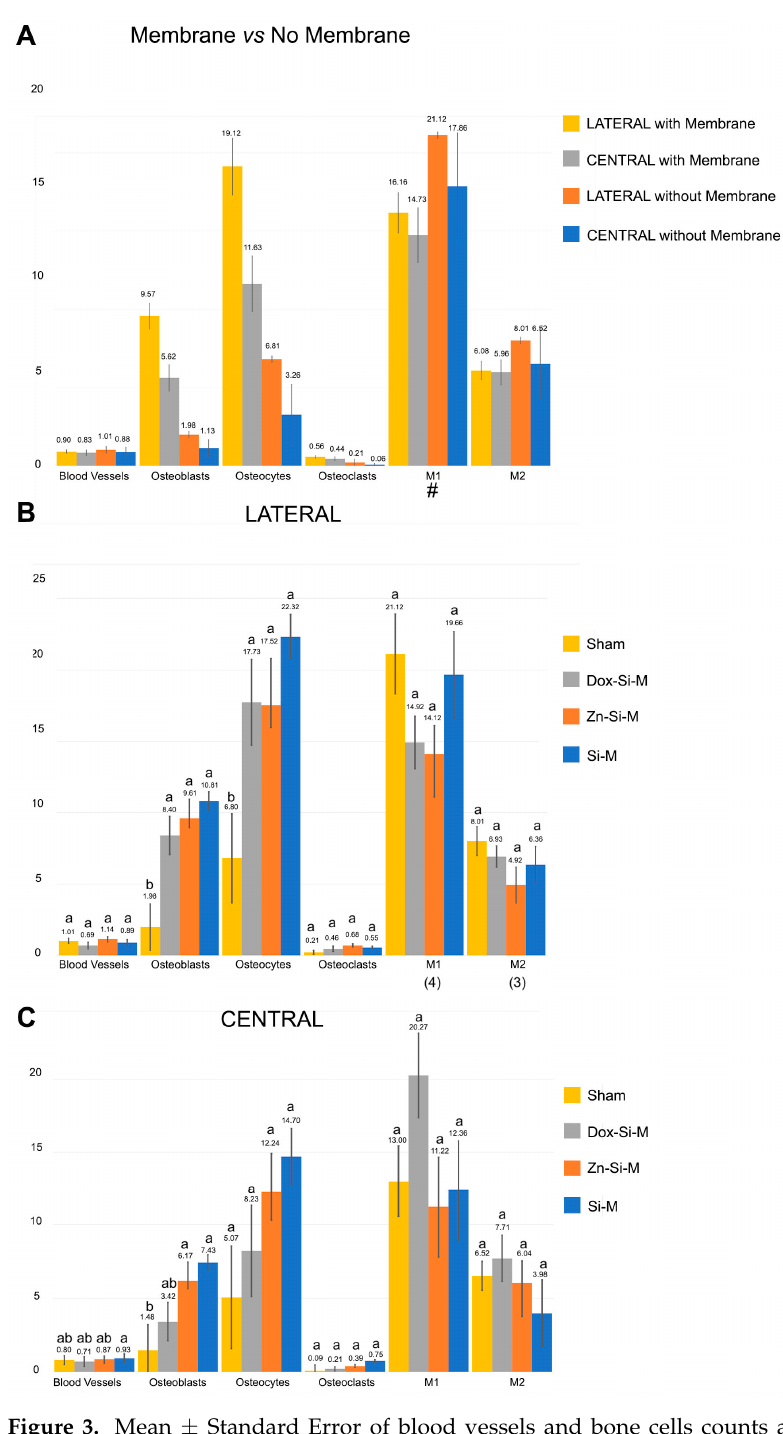
Figure 3. Mean ± Standard Error of blood vessels and bone cells counts at the selected study section when comparing ( A ) the presence of membrane over the defect versus no membrane and ( B ) lateral (R1, R3, R4, R6) and ( C ) central (R2, R5) regions. Statistical results ( p values) after pairwise comparisons. Similar lower-case letters indicate no differences between membranes within the same cell group. Hash means significance ( p < 0.05) after comparing lateral versus central without membrane over the defect. (3) means significance ( p < 0.05) after comparing lateral versus central with Dox-Si-M. (4) means significance ( p < 0.05) after comparing lateral versus central in sham group. The numerical data are collected in Supplementary Material Table